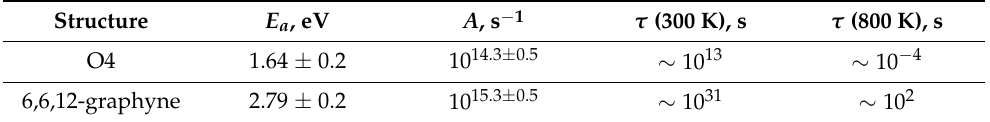
Table 3. Activation energy E a (eV), frequency factor A (s − 1 ), and lifetimes (s) at T 1 = 300 K and T 2 = 800 K, determined from the Arrhenius equation for the crystal structures 6,6,12-graphyne and 6,6,12- graphyne-based oligomer O4.